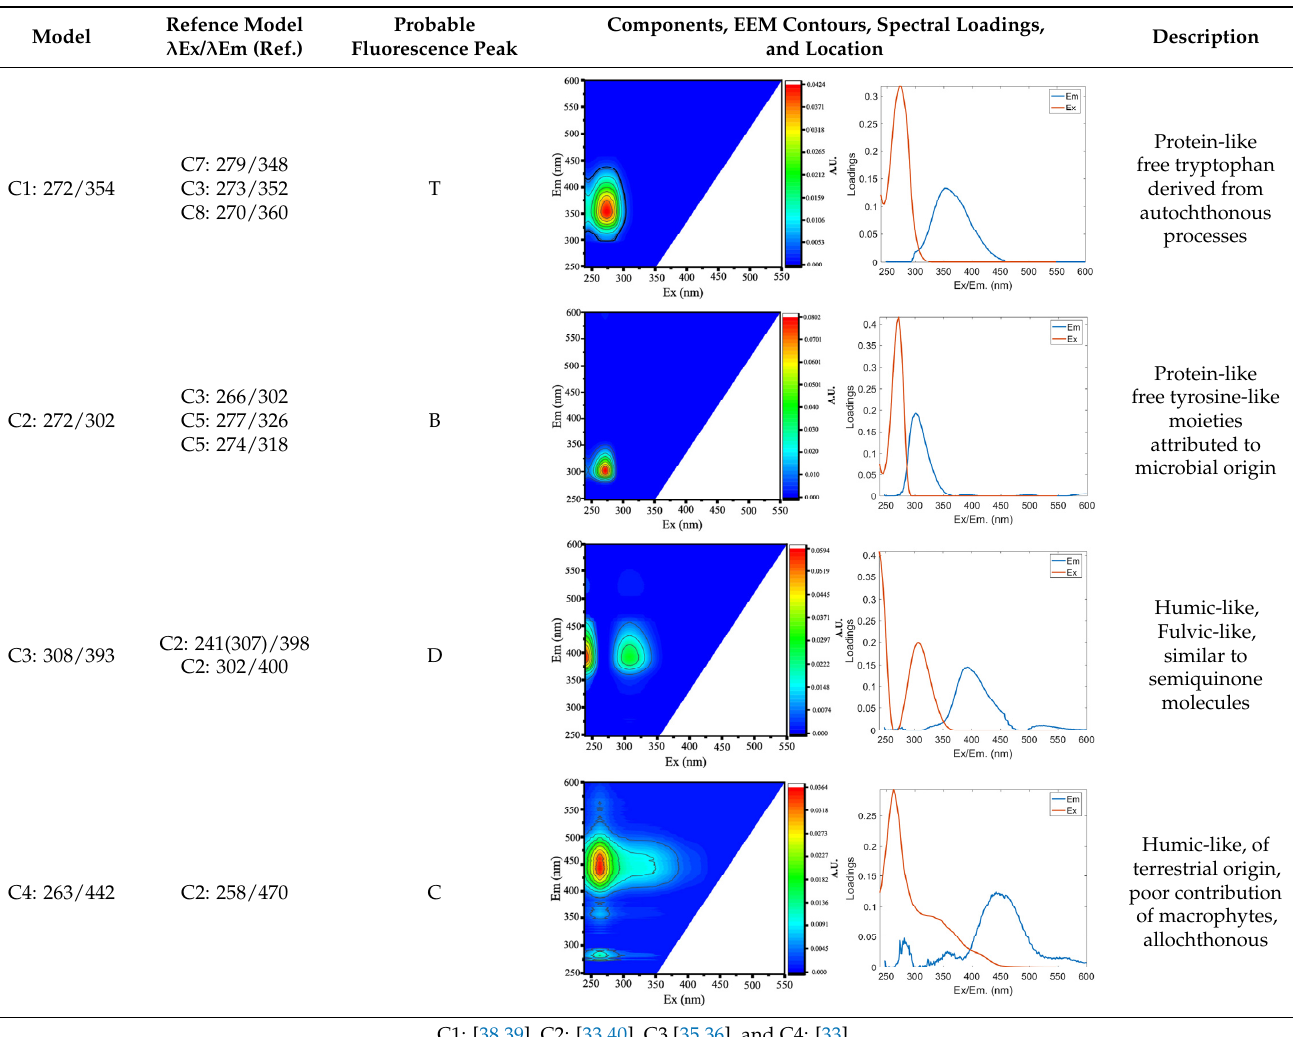
Table 1. EEM positions, EEMs contours, spectral loadings, and loadings of fluorescent components of AEs and LEs determined using the EEM-PARAFAC model and the corresponding fluorescence peaks.